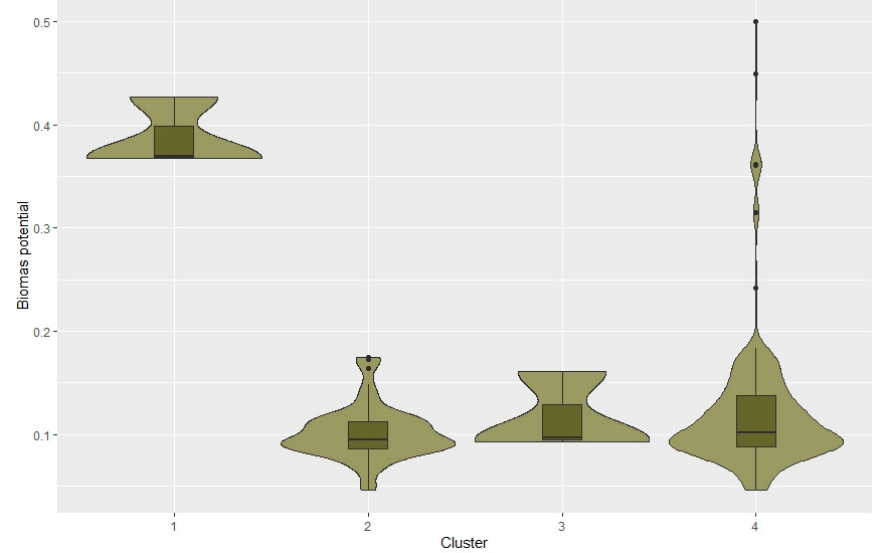
Figure 8. Biomass potential distribution for clusters.